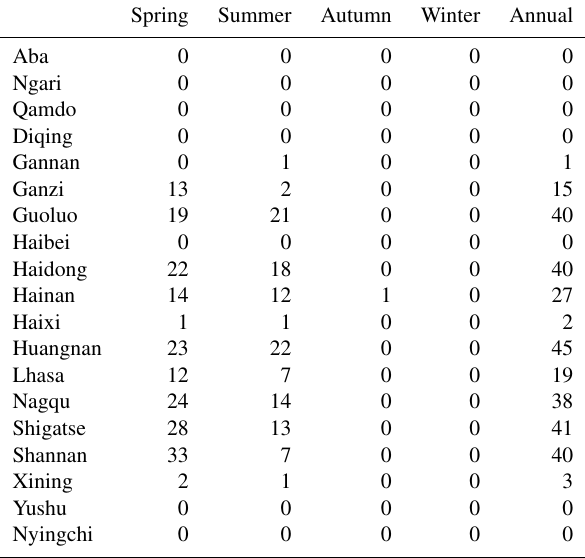
Table 5. The mean nonattainment days (8h O 3 level > 100µgm − 3 ) in 19 prefecture-level cities over the Tibetan Plateau each